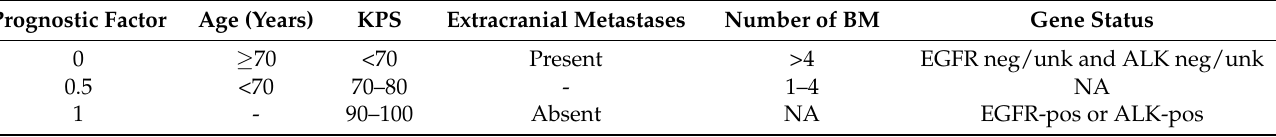
Table 2. Lung-molGPA (Lung Cancer Molecular Markers Graded Prognostic Assessment).